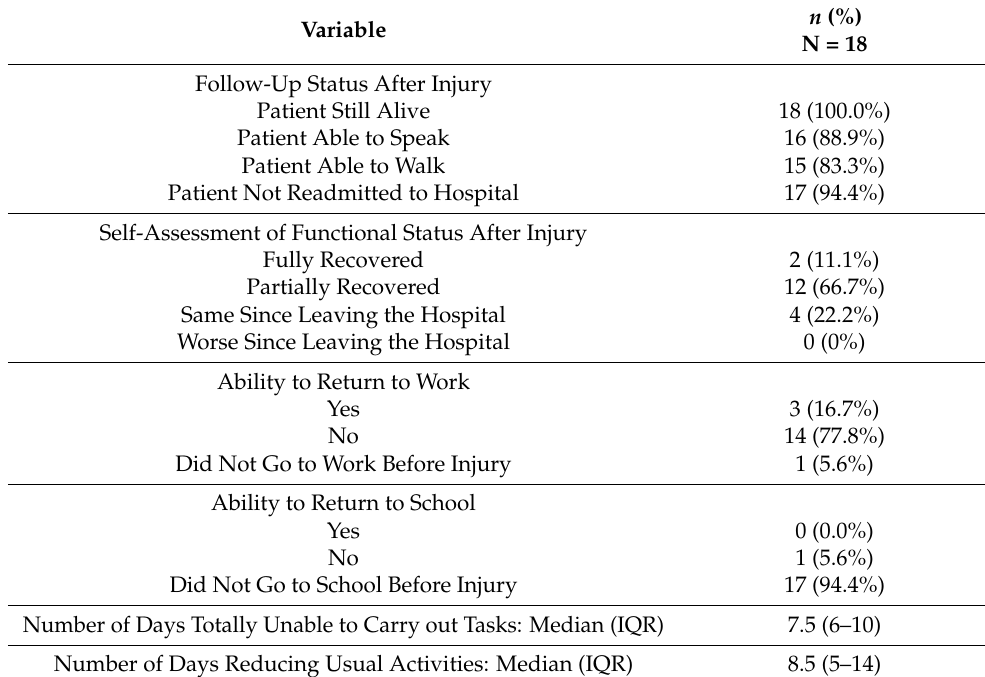
Table 3. Self-assessment of functional status after at 28-days post-injury.